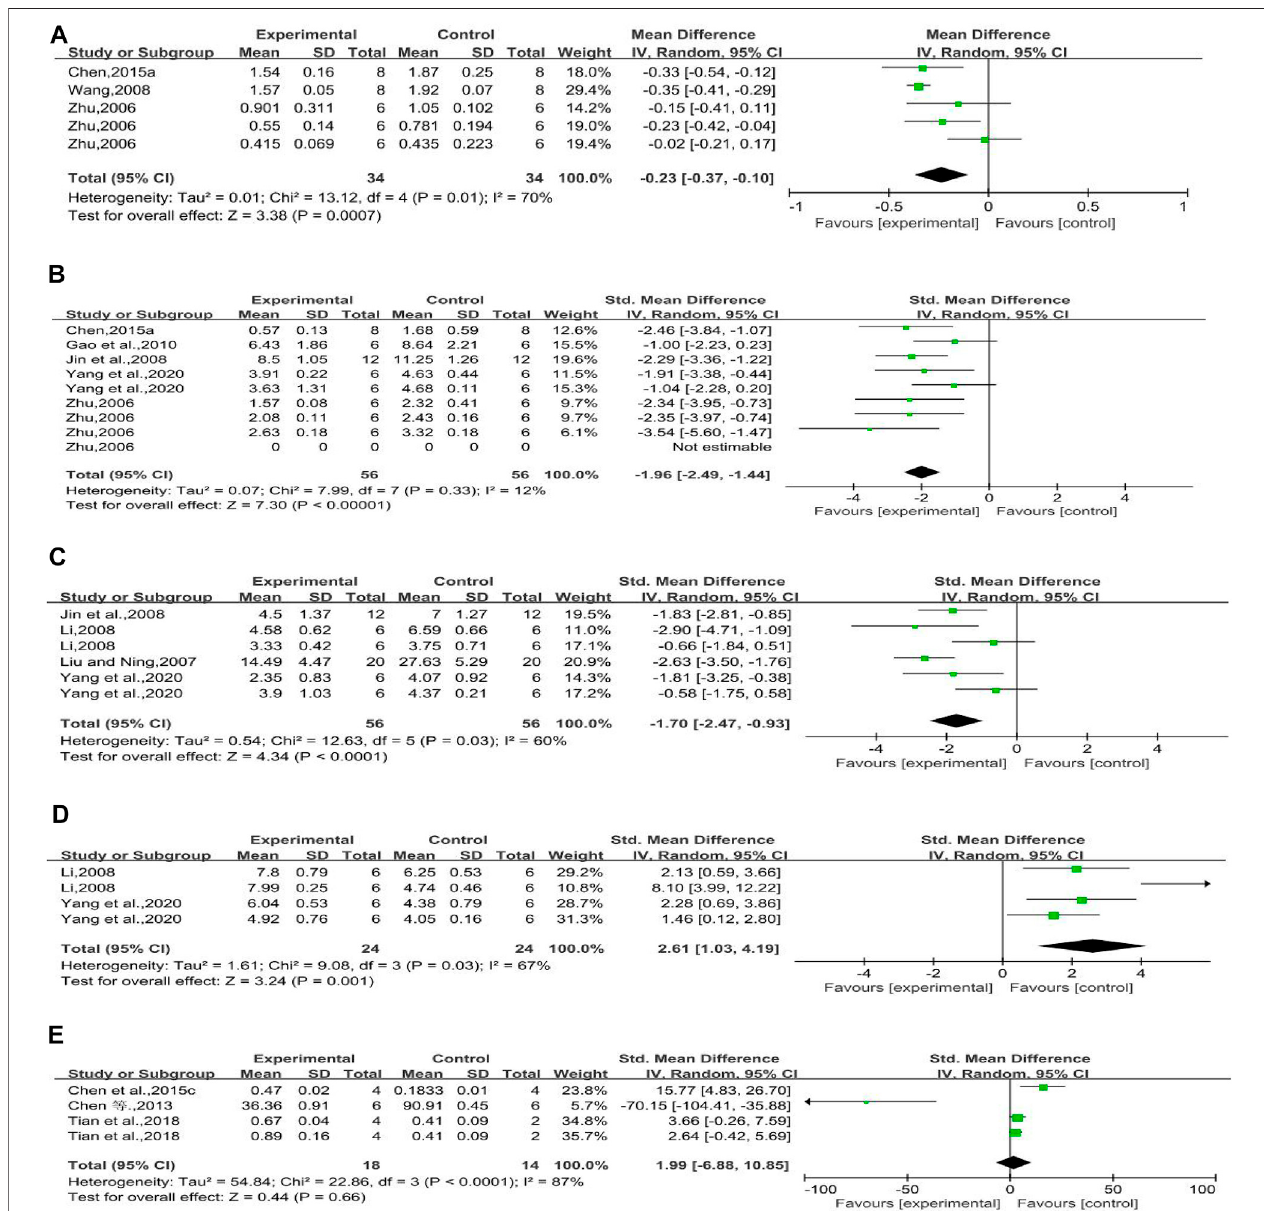
FIGURE5|(A) ForestplotofTGF- β 1mRNA, (B) forestplotofTGF- β 1protein, (C) forestplotof α -SMAprotein, (D) forestplotofE-cadprotein,and (E) forestplotof nephrin protein.